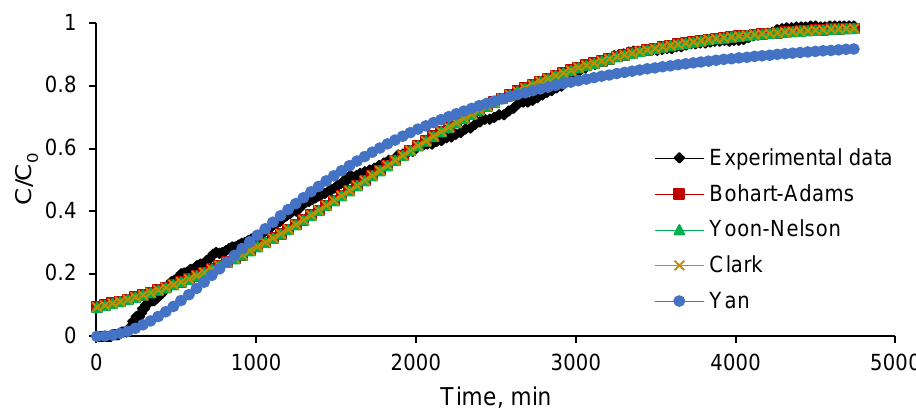
Figure 5. Effect of working parameters on breakthrough curve for ethacridine lactate biosorption onto SPRBA 5% biosorbent.